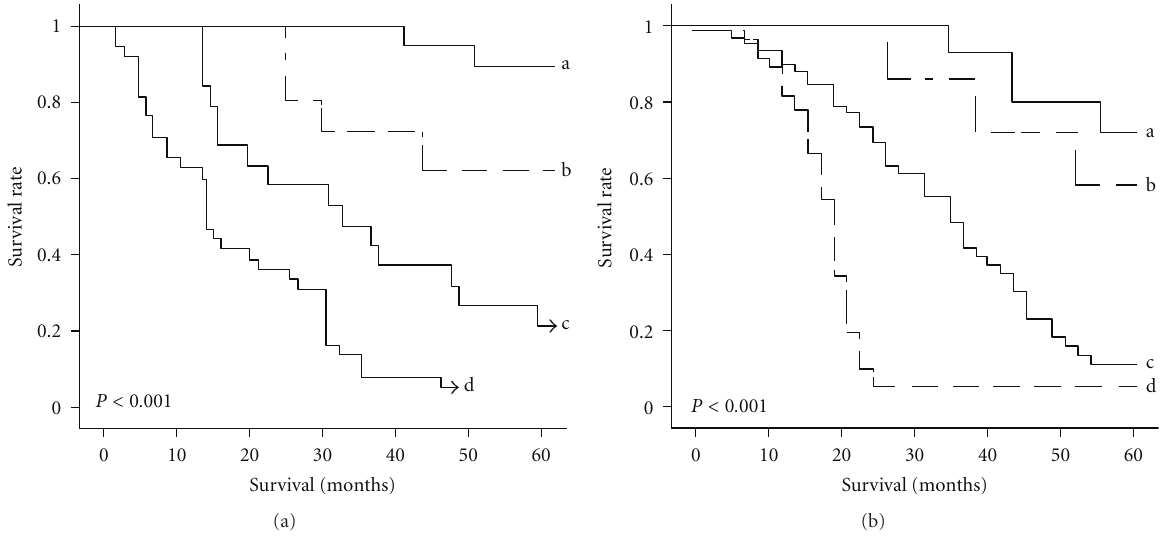
Figure 5: Postoperative survival curves for patterns of patients with glioma and MPG expression. (a) Kaplan-Meier postoperative survival curve for patterns of patients with glioma and MPG expression. (b) Cox-proportional hazards model after adjusting for age, gender, and grade. MPG might be an independent predictor of survival, without consideration of age, gender or grade. “a” refers to MPG-negative expression group; “b” refers to MPG-weak positive (+) expression group; “c” refers to MPG-moderate positive (++) expression group; “d” refers to MPG strong positive (+++) expression